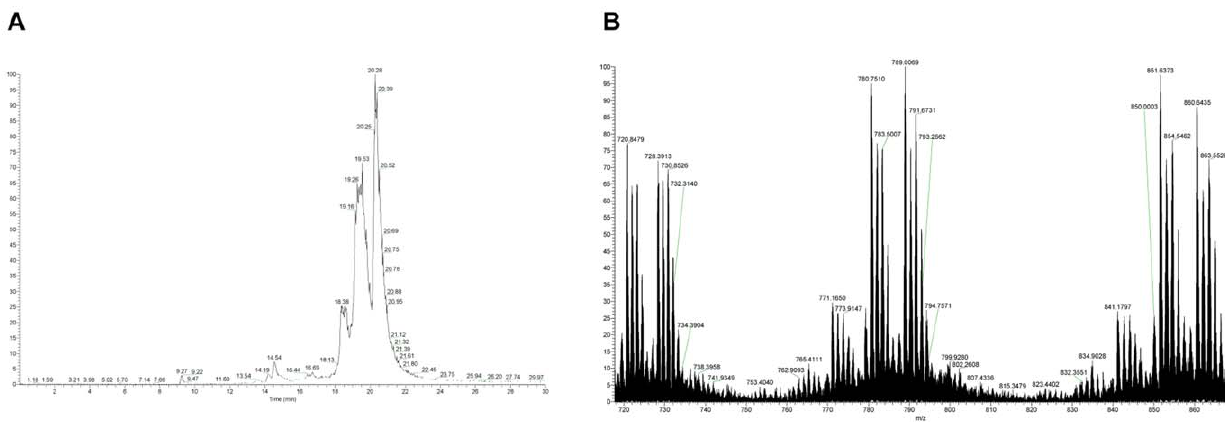
Figure 2. Non-digested oxidized synthetic hPTH(1–84)ox. A: NanoLC-ESI-FTMS total ion chromatogram. B: Magnified summed FTMS spectrum for retention time interval 18.30–20.50 minutes. Several different charged analyte ions were detected.